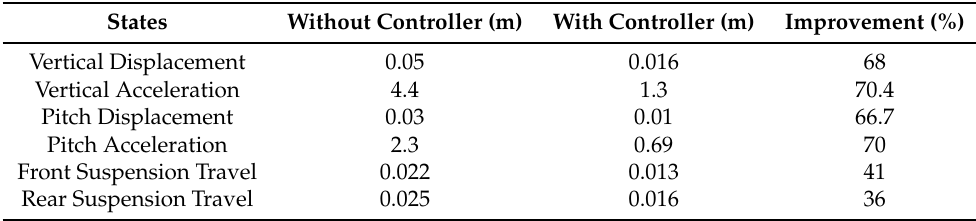
Table 3. RMS values comparison with previous